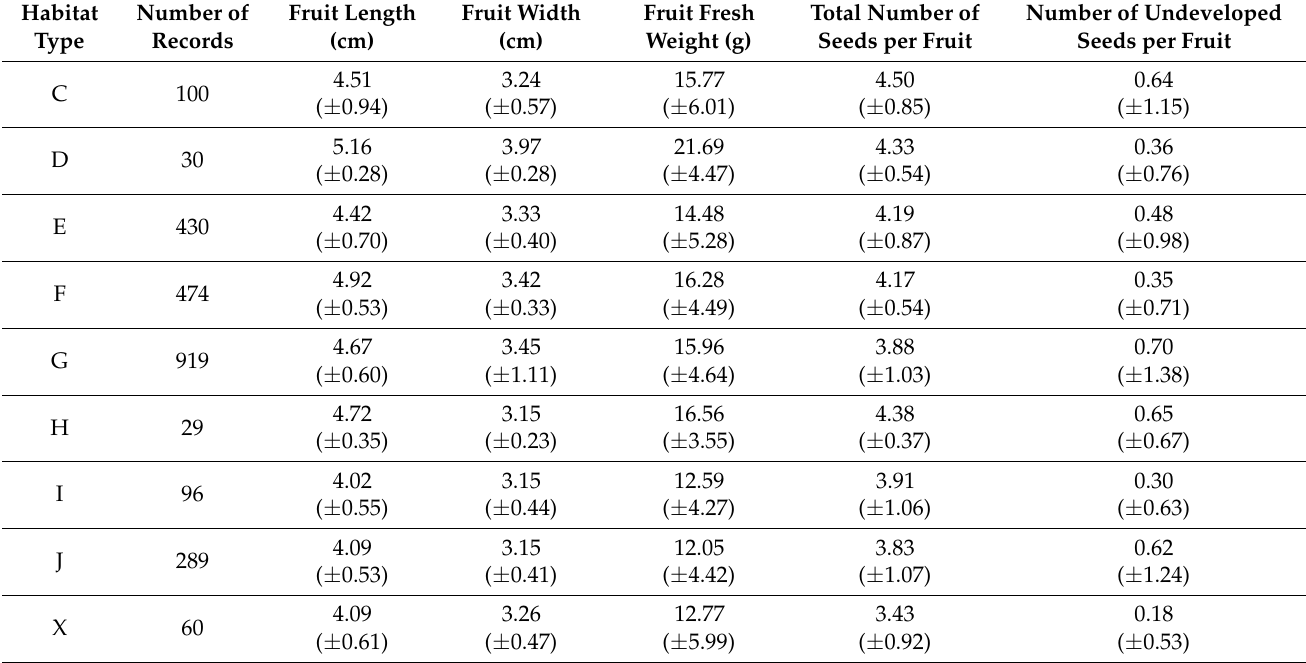
Table 2. The fruit and seed traits (mean ± SD) of Echinocystis lobata in inland surface waters (C); mires, bogs, and fens (D); grasslands and lands dominated by forbs, mosses, or lichens (E); heathland, scrub, and tundra (F); woodland, forest, and other wooded land (G); inland unvegetated or sparsely vegetated habitats (H); regularly or recently cultivated agricultural, horticultural, and domestic habitats(I); constructed, industrial, and other artificial habitats (J); habitat complexes